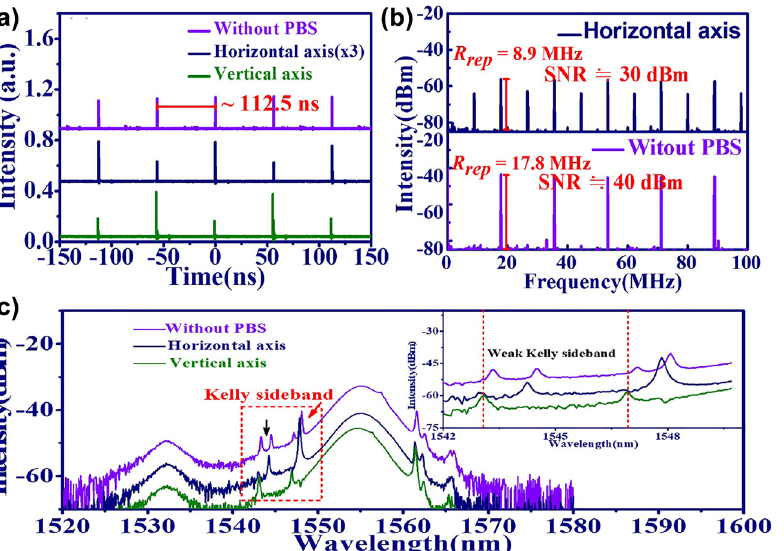
Figure 4: PR-GVLVSs from EDFL based on GO/PVA film. (a) Time trace, (b) RF spectrum, and (c) optical spectrum and zoomed in spectrum of Kelly sidebands (inset figure). (Without PBS: purple line, horizontal axis: navy line and vertical axis: green